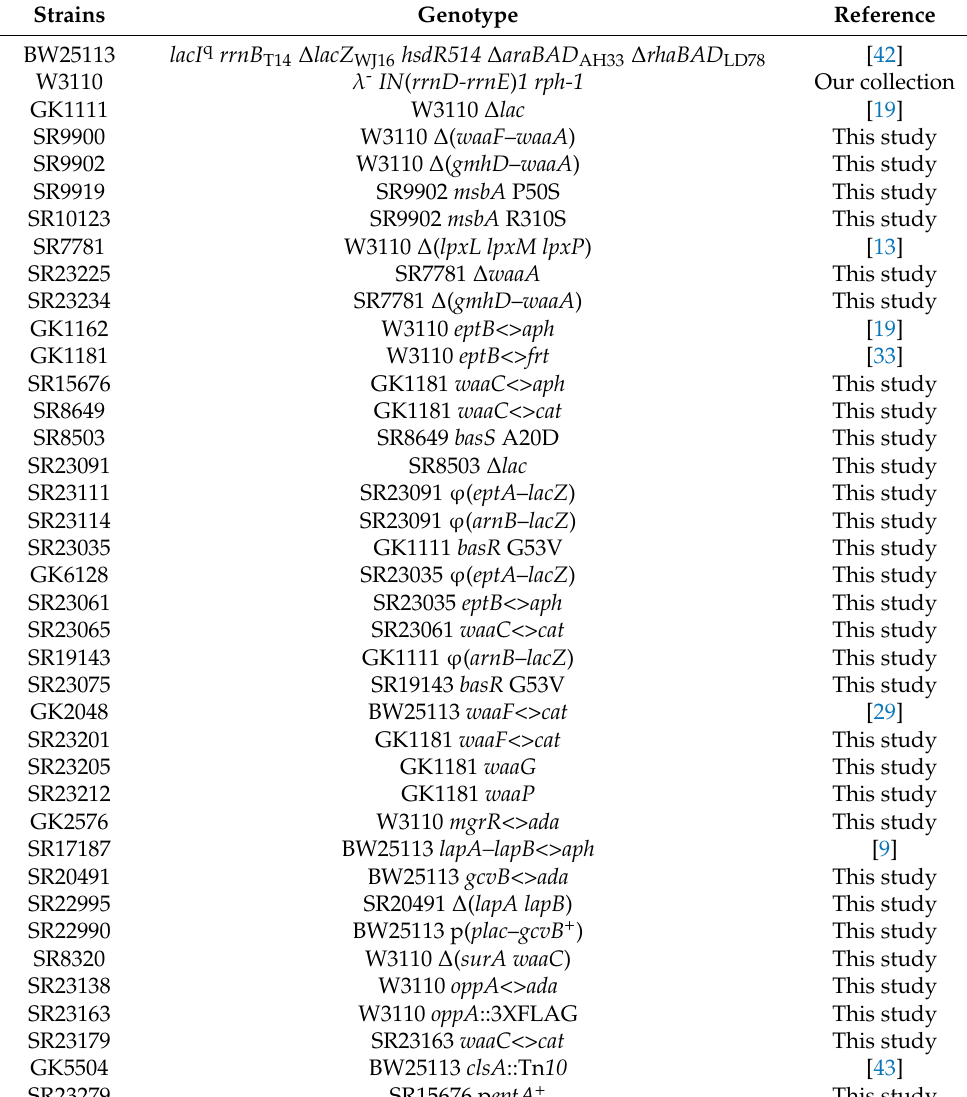
Table 1. Strains used in this study. Additional strains are shown in Section 2.6.